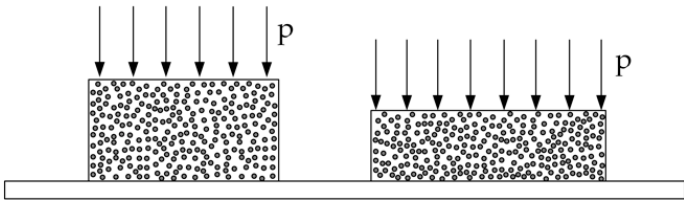
Figure 25. Schematic illustration of transverse squeeze flow.